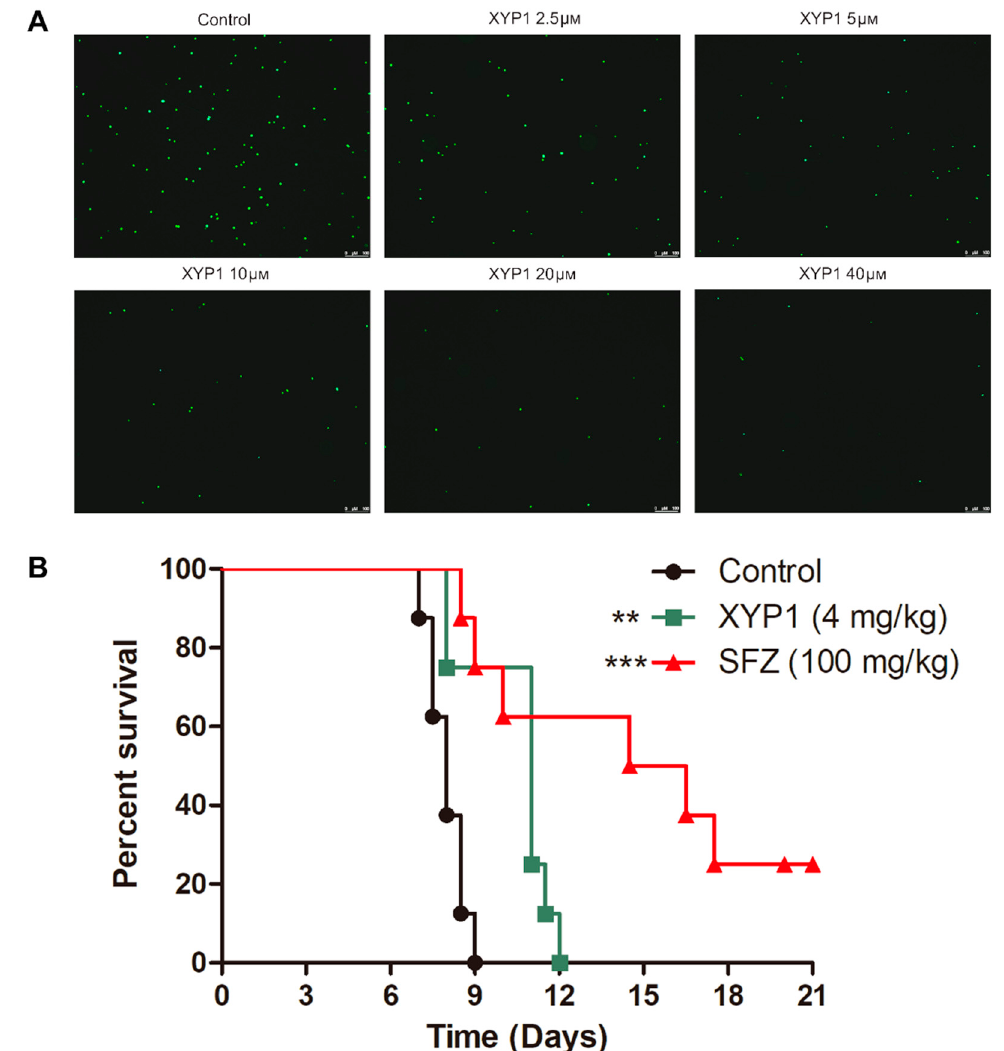
Figure 2. Anti- T . gondii effects of XYP1 in vitro and in vivo. ( A ) Viability assessment of T. gondii tachyzoites evaluated by fluorescence microscope. RH-GFP of tachyzoites were treated with different concentrations of XYP1 or DMEM alone (control) for 2 h. The fluorescence intensity was observed using a fluorescence microscope. Scale bars = 100 µ m. ( B ) Effect of XYP1 and SFZ on the survival rate of infected mice. RH 2F strain tachyzoites. Beginning on the day of infection, XYP1 at 4 mg/kg, vehicle (PBS) or positive drug (SFZ) at 100 mg/kg was intraperitoneally administered for 7 days. These mice were observed for an additional 14 days, and the survival times of the infected mice were recorded for 21 days ( n = 8 for each group). A log-rank test demonstrated that SFZ and XYP1 statistically prolonged the survival time of infected mice compared with the vehicle group ( *** P < 0.0001, ** P < 0.01).